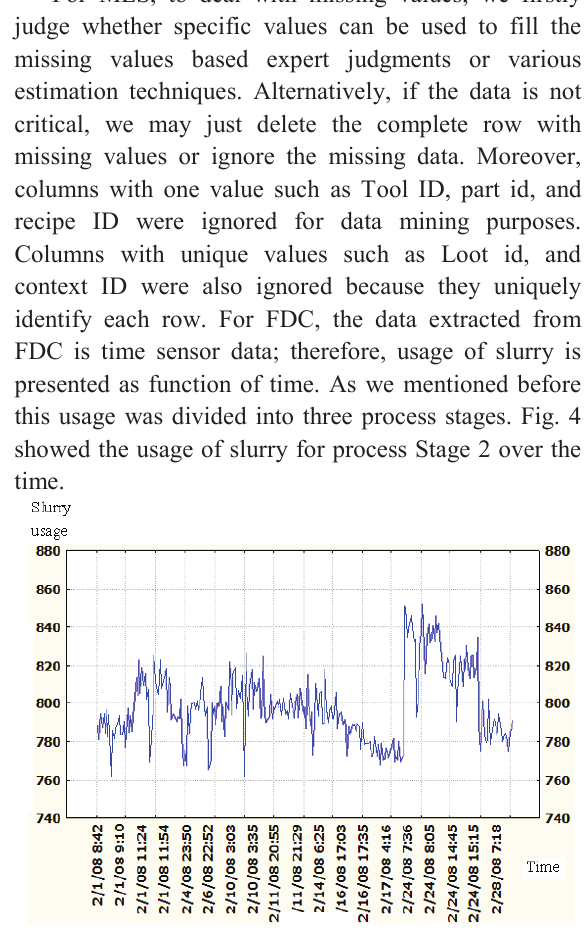
Fig. 4. Slurry usages at Stage